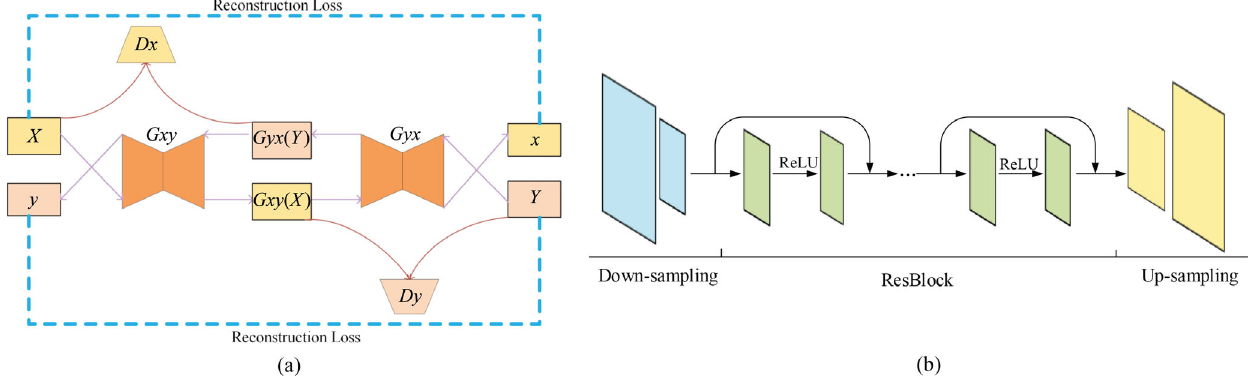
Fig. 5 (a) Convolutional neural network framework. (b) Structure of the